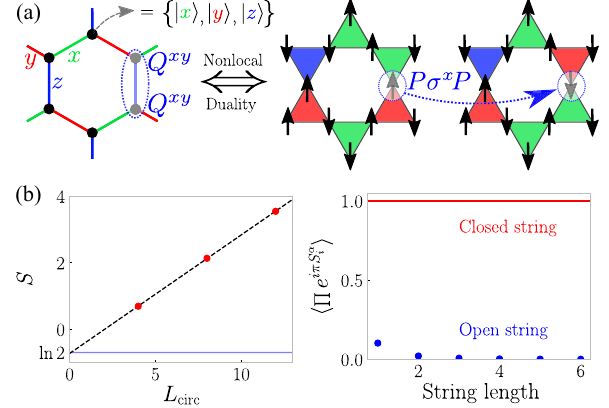
FIG. 5. Spin-1 quadrupolar Kitaev liquid and its dual frustrated PXP kagom´e model. If we consider our spin- 3 = 2 parent model H of an emergent dimer model with e -anyon fluctuations, then e - e in the large field/fluctuation limit, we obtain an effective spin-1 model on the honeycomb lattice (see Sec. III C). (a) Its inter- actions are Kitaev-like, except with quadrupole operators Q αβ rather than spin operators S α . This is dual to the frustrated Ising model on the kagom´e lattice, in the weak-field limit where we project the transverse field σ x into a PXP -type term. (b) Since the latter is known to be disordered [106 – 109], we learn that the dual spin-1 quadrupolar Kitaev model forms a Z 2 topological liquid. We independently confirm this by finding a topological entan- glement entropy γ ≈ ln 2 , and by showing that while closed loops of the Wilson operator are unity in the ground state, open strings decay exponentially fast; the latter is a sign of one-form symmetry breaking which defines topological order [93,94], and can be interpreted as a limiting case of the Fredenhagen- Marcu string order parameter [132 – 135], detecting that e -anyons have not